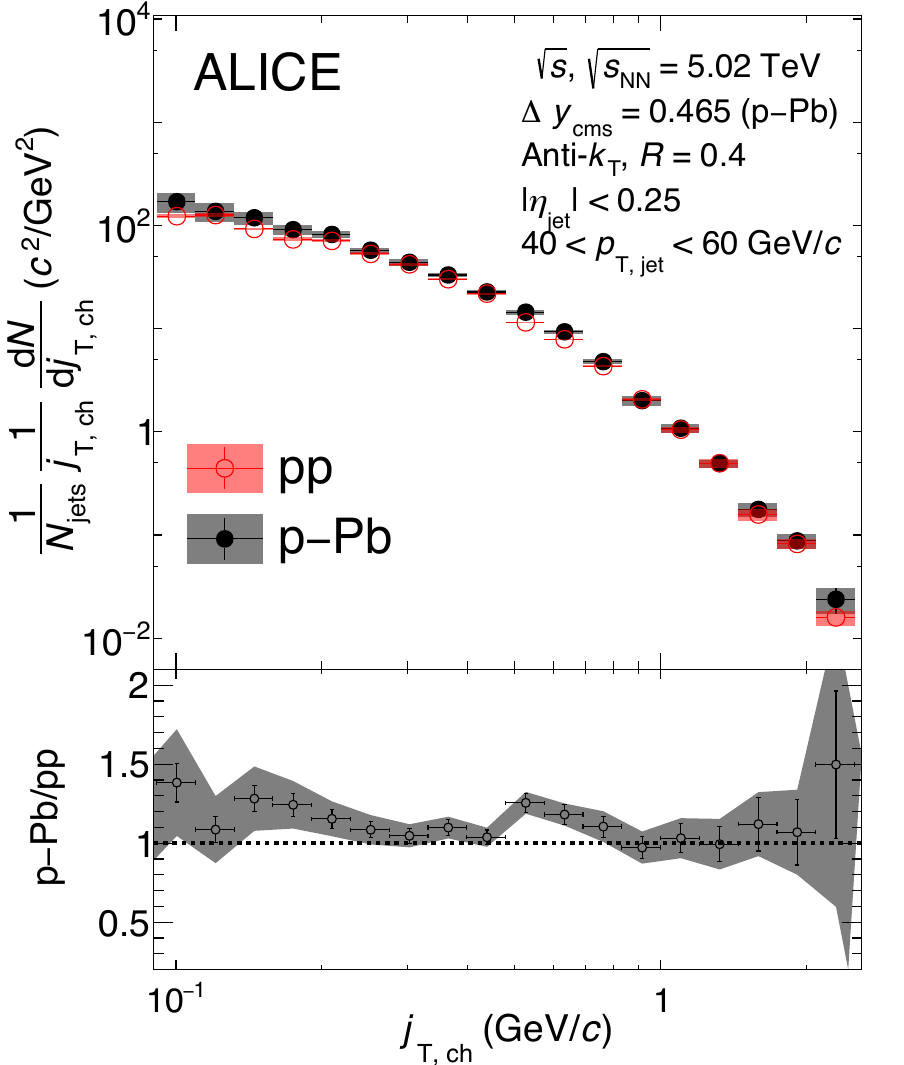
√ √ s , s NN = 5.02 TeV